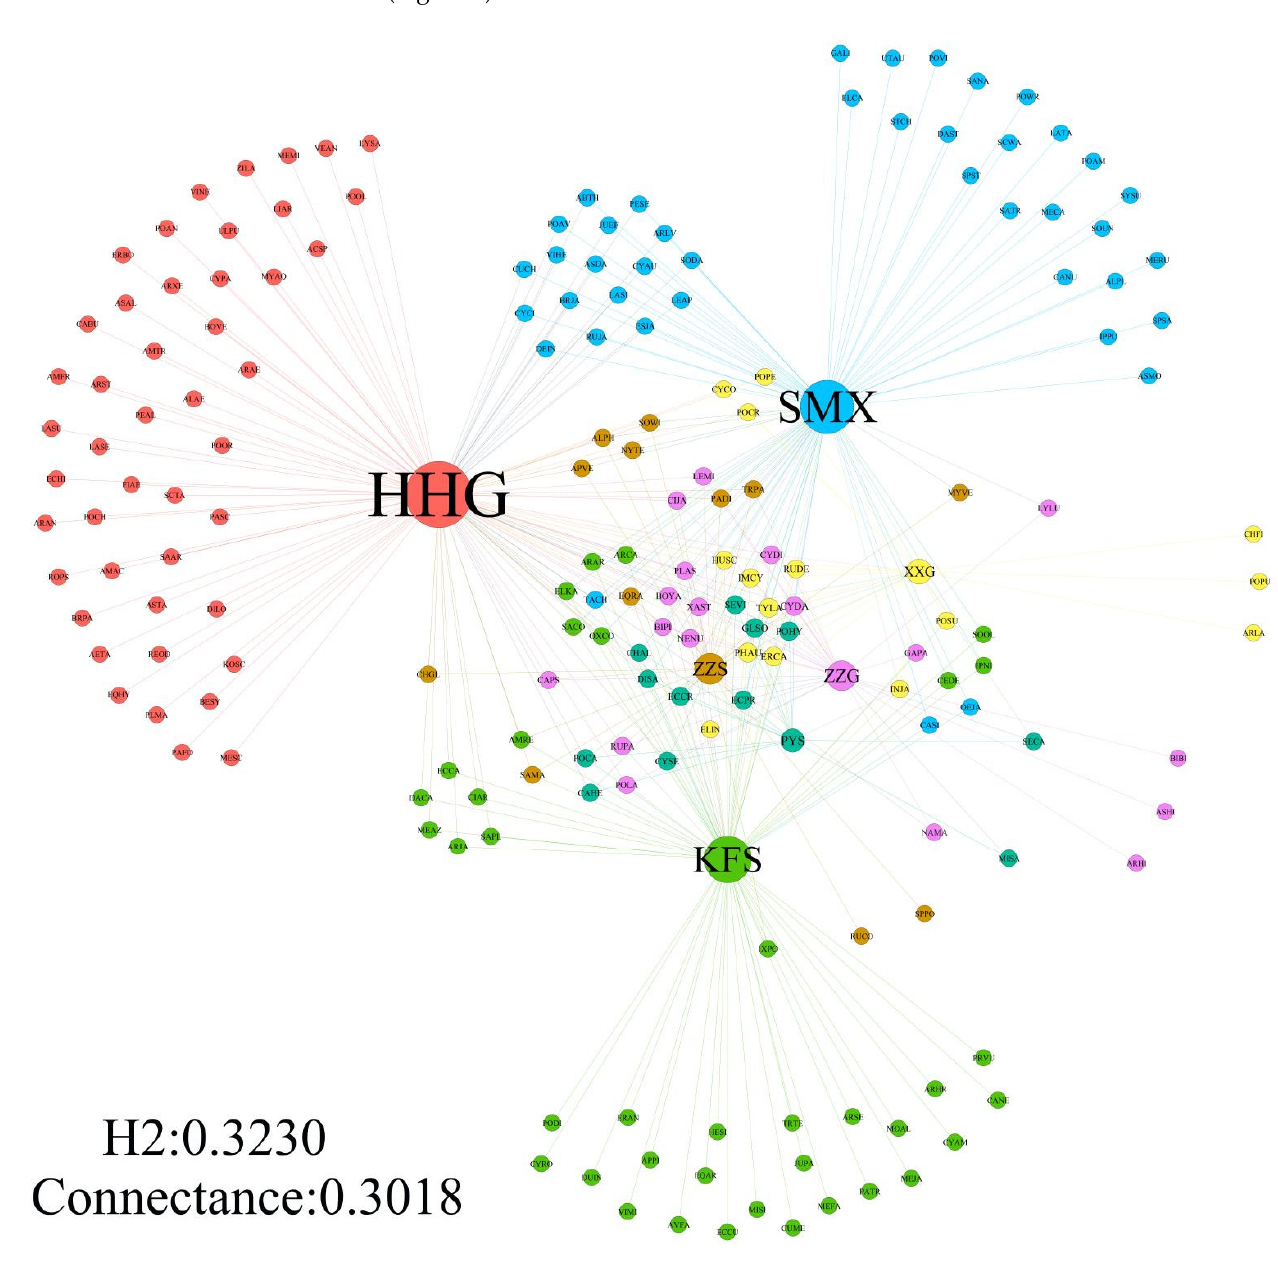
Figure 3. Network analysis of wetland plant composition in the seven nature reserves of the Yellow River in Henan Province, China. The size of the dot indicates the abundance of species. Small letters in small circles indicate plant species. Different colors represent different nature reserves. HHG, Henan Yellow River wetland national nature reserve. SMX, Sanmenxia reservoir area wetland. ZZS, Henan Zhengzhou Yellow River wetland provincial nature reserve. ZZG, Henan Zhengzhou Yellow River national wetland park. KFS, Henan Kaifeng Liuyuankou wetland provincial nature reserve. XXN, Henan Xinxiang Yellow River wetland birds national nature reserve. PYS, Henan Puyang Yellow River wetland provincial nature reserve.